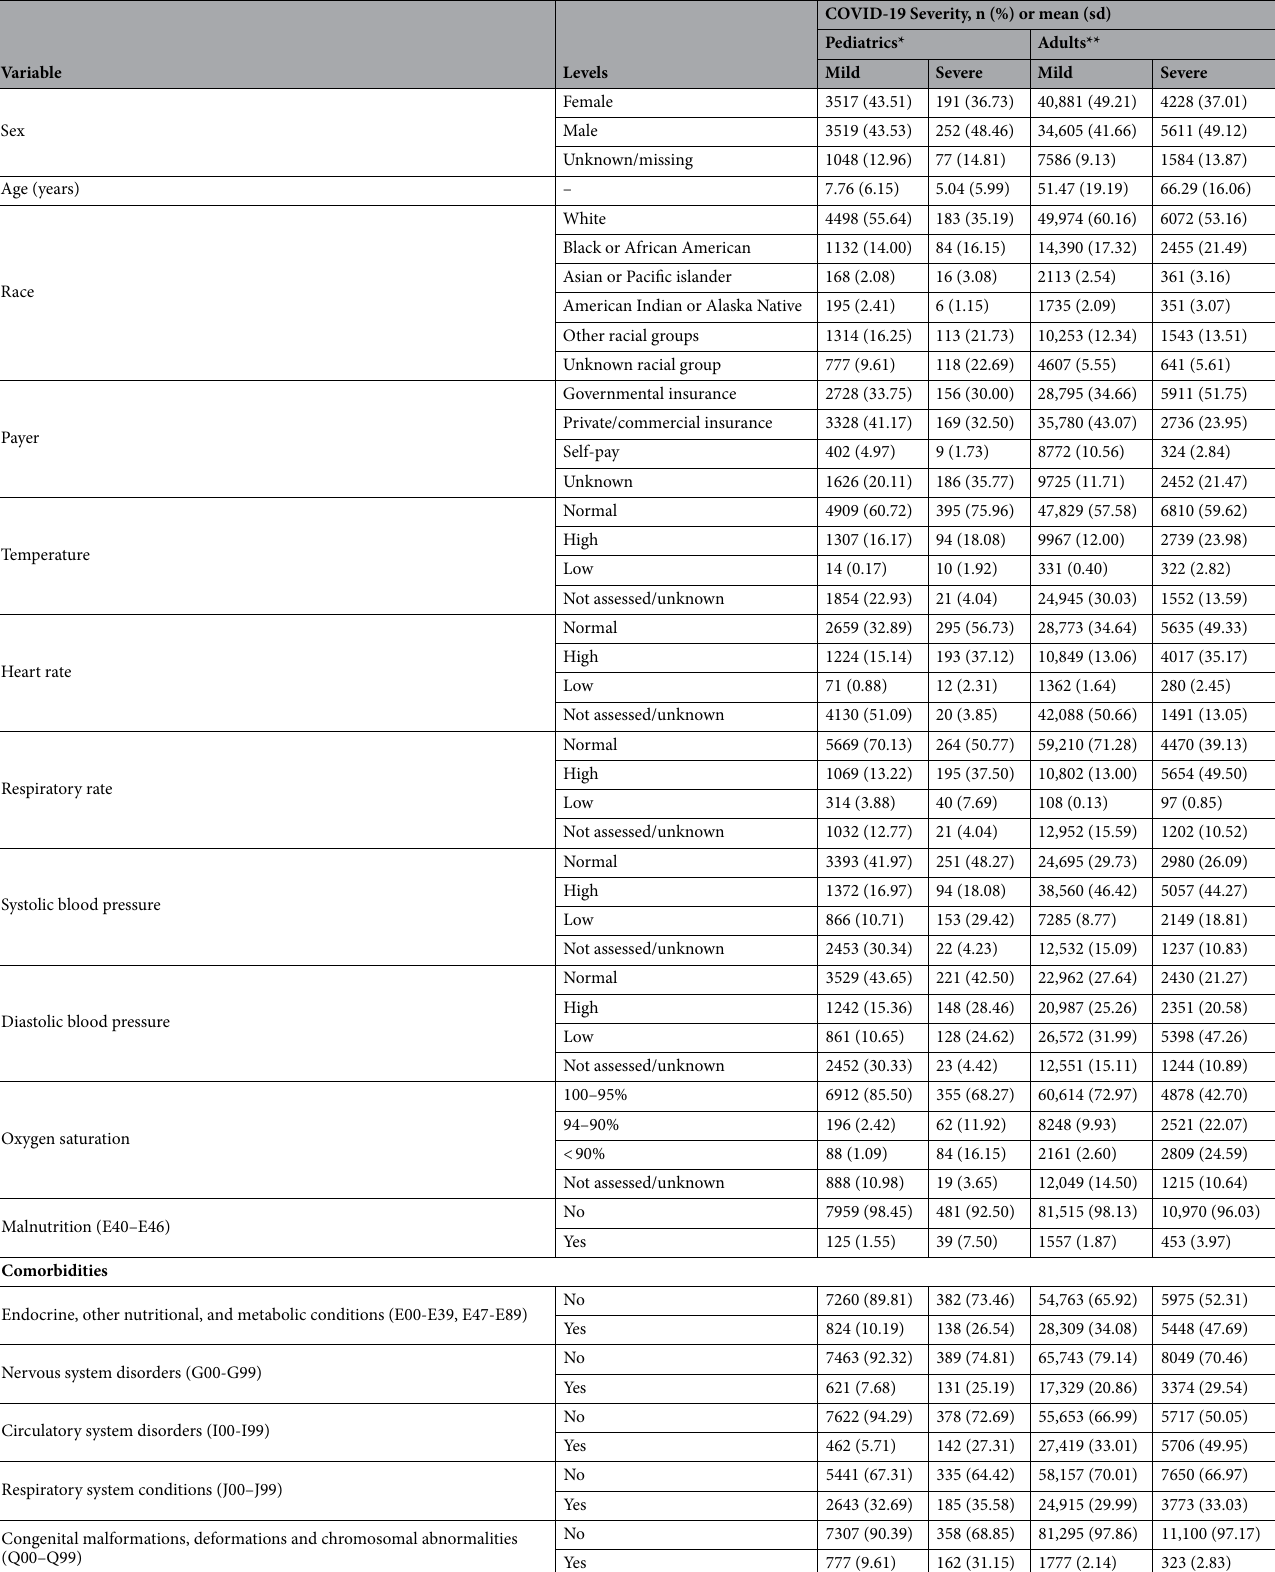
Table 1. Summary statistics. *All p values are less than 0.0001 except patient sex (0.0101) and respiratory comorbidities (0.1908). **All p values are less than 0.0001 without